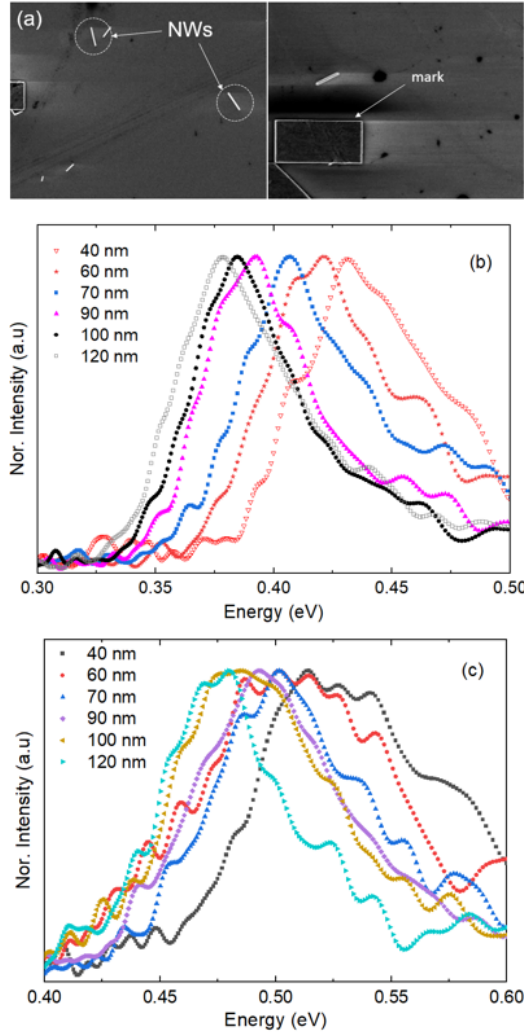
Figure 4. ( a ) SEM micrographs of the InAs nanowires transferred onto a marked Si/SiO 2 substrate. Photoluminescence spectra of different diameter nanowires taken at 8 K, ( b ) zincblende ( c )